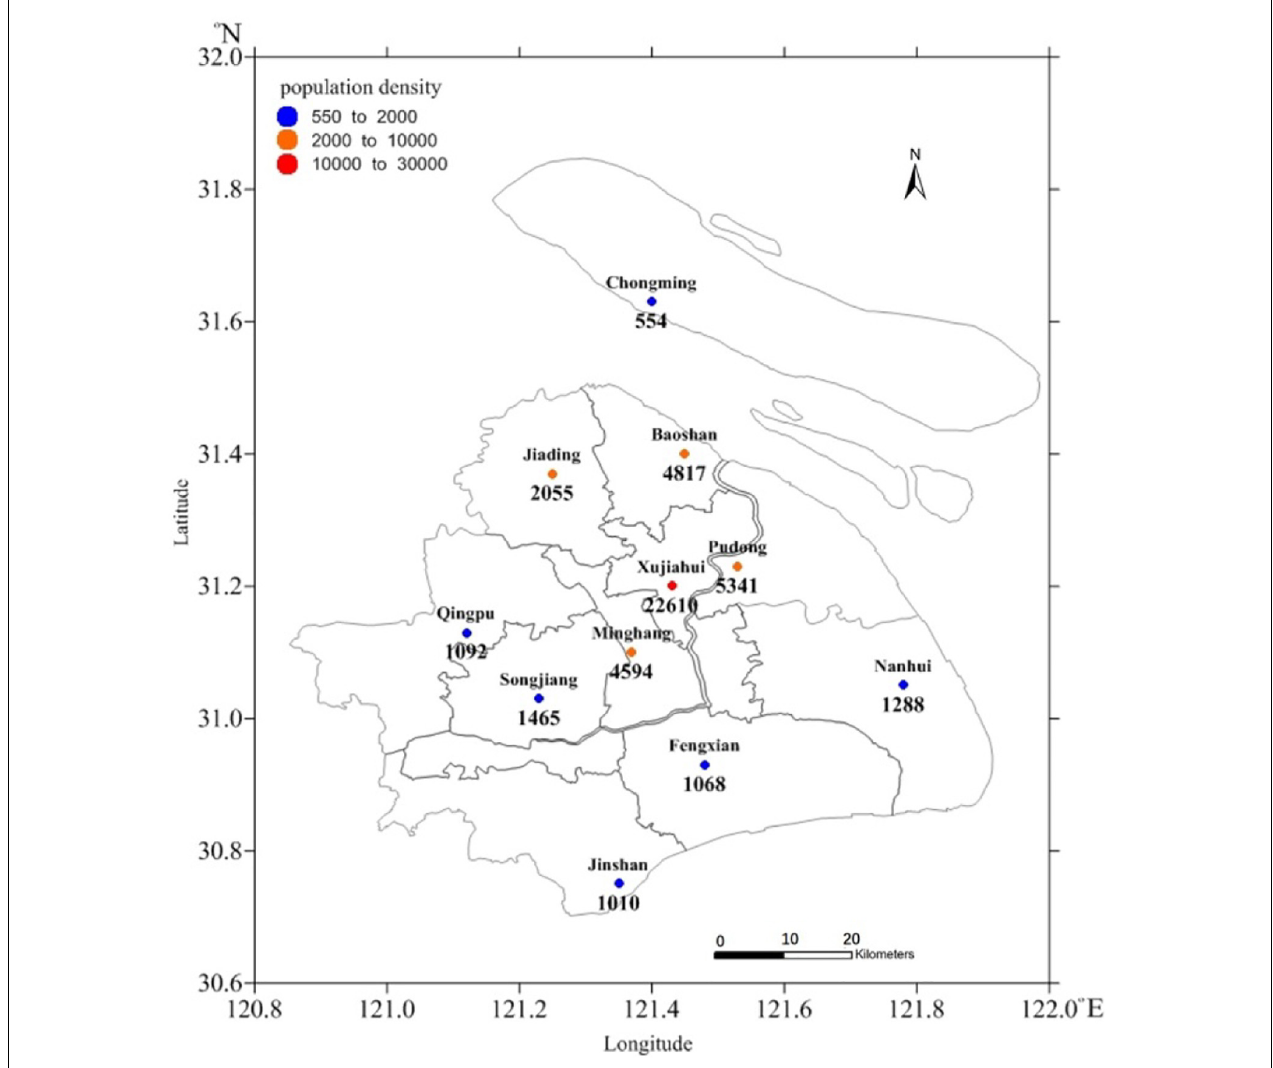
FIGURE 1 | Distribution of 11 meteorological stations in Shanghai and the population density in each district in 2005 (unit: persons per square kilometers).